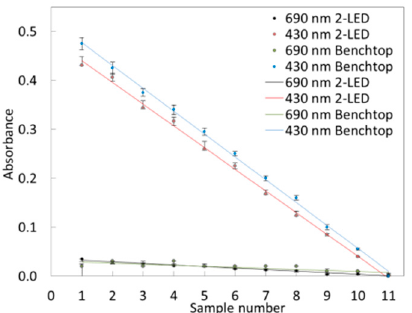
Figure 6. Comparison between the 2-LED-µSpectrophotometer and a commercial benchtop spectrometer. Measurements regarding sensitivity using two wavelengths and standard UV/vis-cuvettes, selected wavelengths λ 1 = 430 nm and λ 2 = 690 nm. Absorbance measurements of dilution series are an example that includes the concentrations in a number of dilutions.